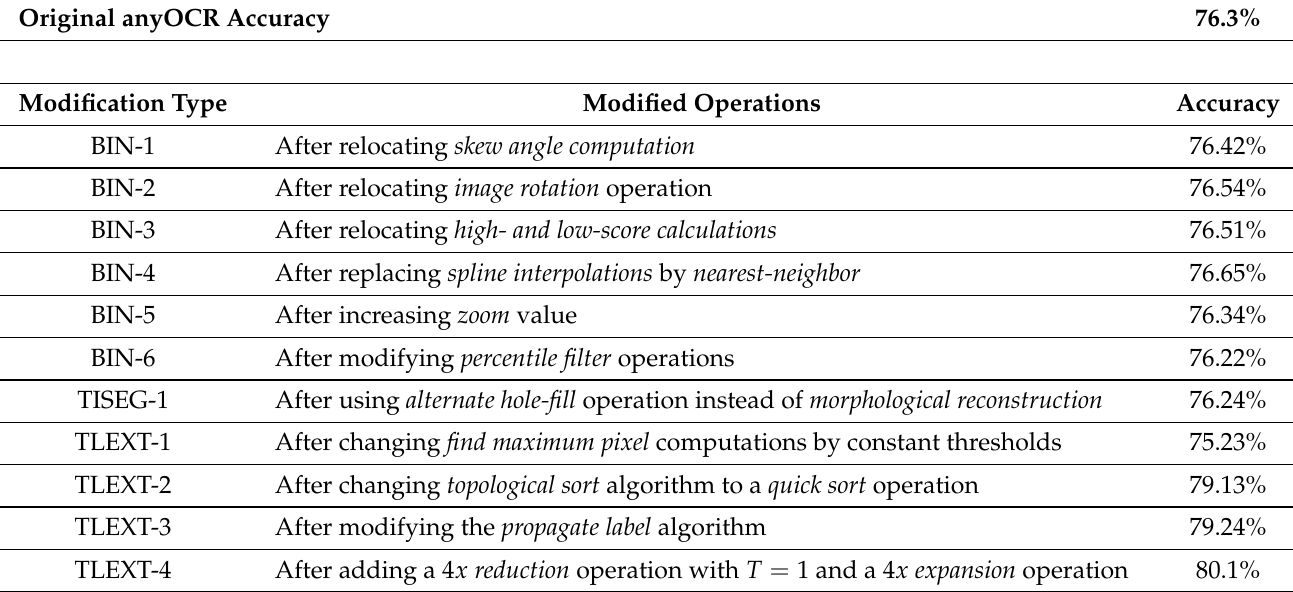
Table 2. Algorithmic optimization effects on system accuracy (for test dataset